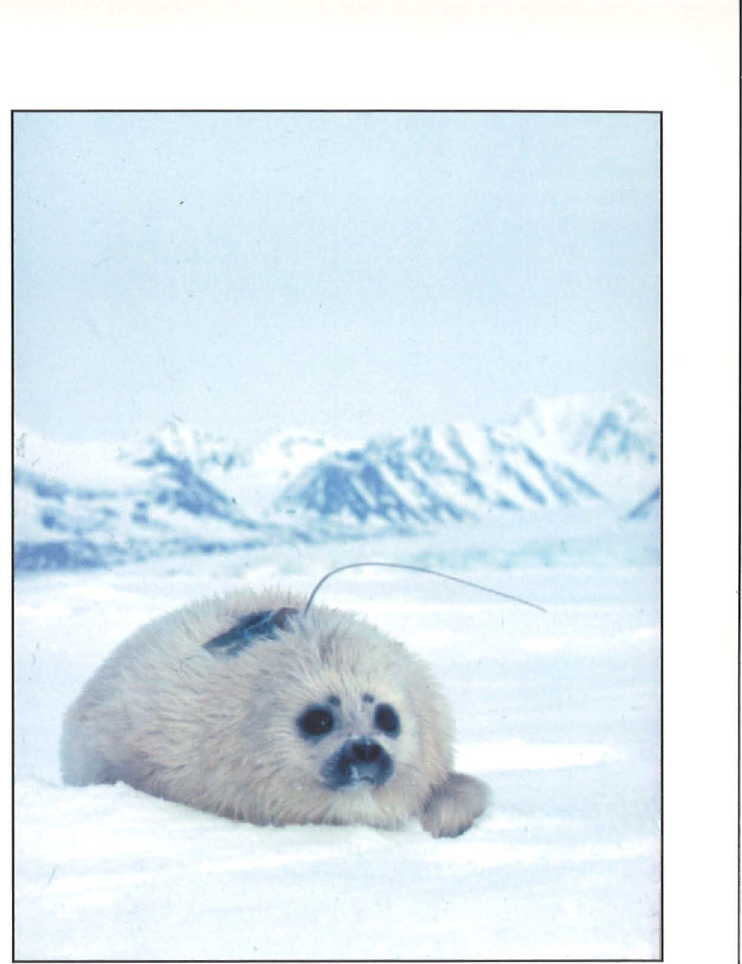
Ringed seal pup with VHF trans mitter and time depth recorder used in a dive